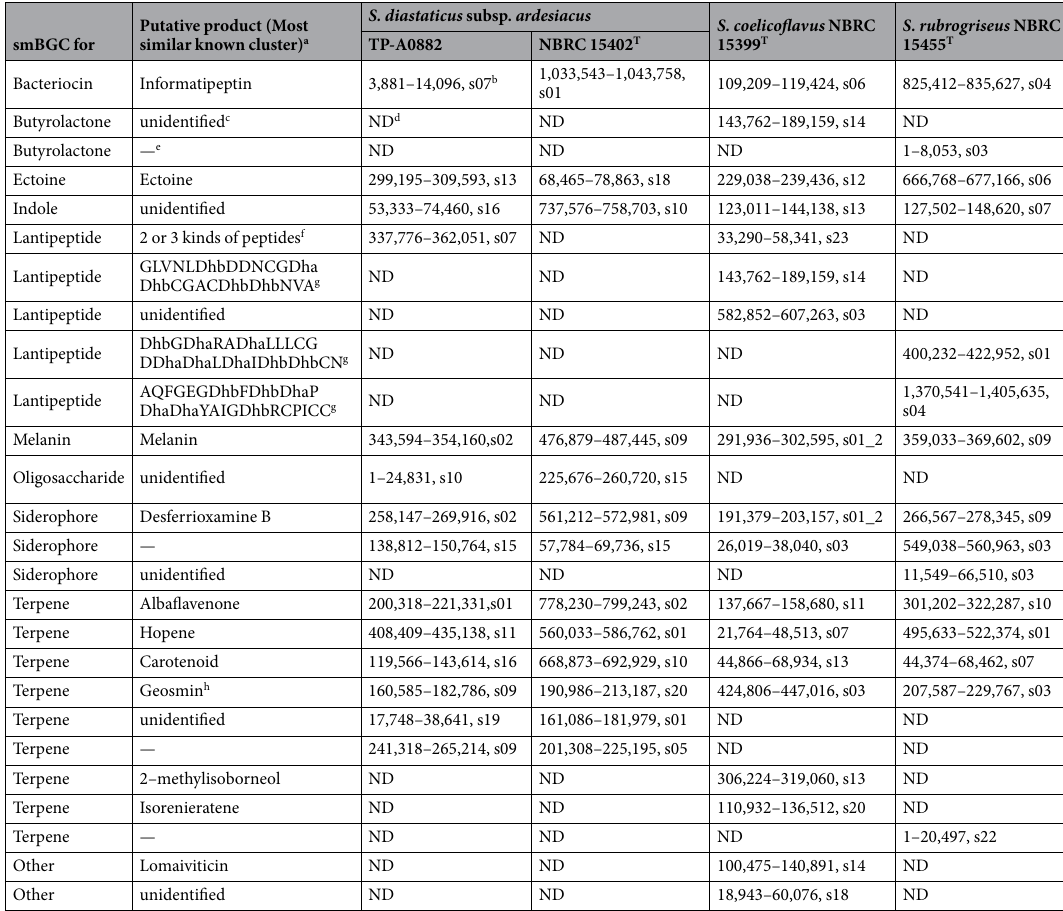
Table 7. Loci encoding the other smBGCs in the draft genome sequences. a When the outputs of antiSMASH showed > 40% gene similarities, we putatively considered them as putative products; b Locus is shown as start-end positions and scaffold no. (sxx means scaffold000xx); c As analysis using antiSMASH output product names but the gene similarities were less 40% gene similarity, the products are shown as unidentified; d Not detected; e No output; f